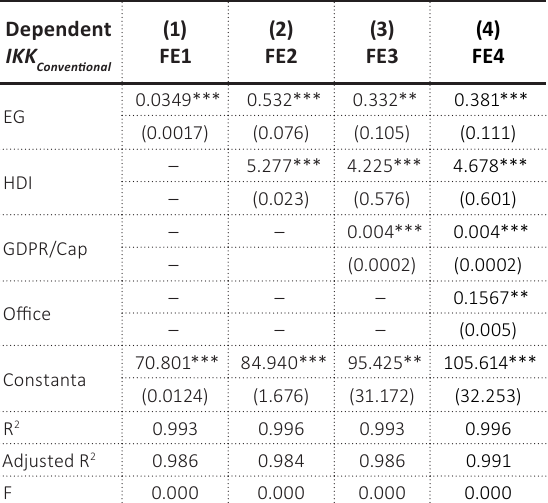
Table 6. Effect of EG, HDI, GDPR/Cap and Office on IKK Conventional